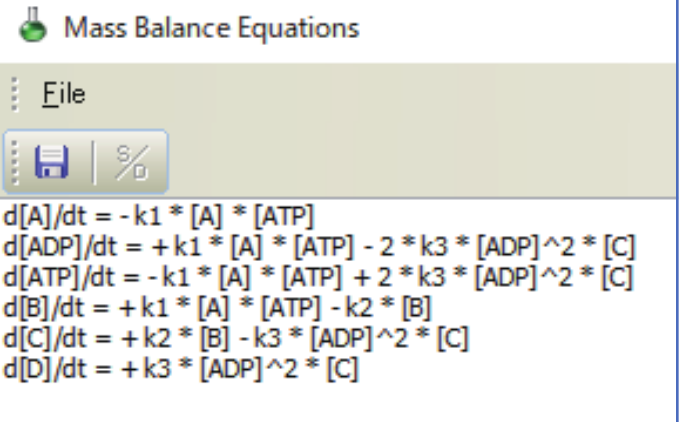
Figure 7. Mass balance equations derived automatically from Figure 6 using a reaction scheme created in